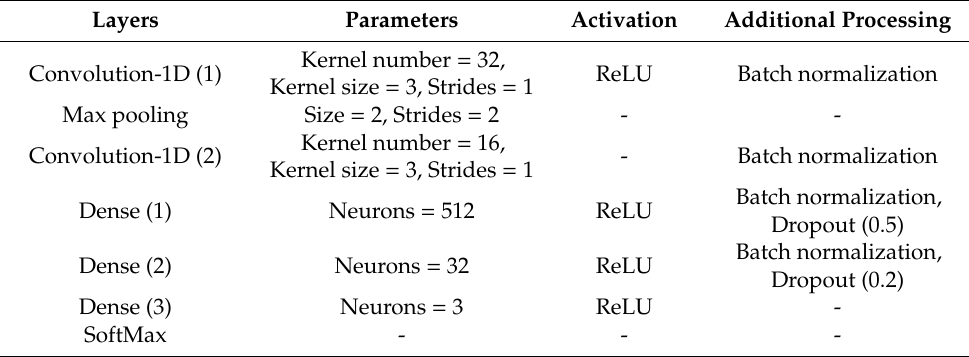
Table 1. Layers and parameters of the designed convolutional neural network (CNN) architecture. Layers Parameters Activation Additional